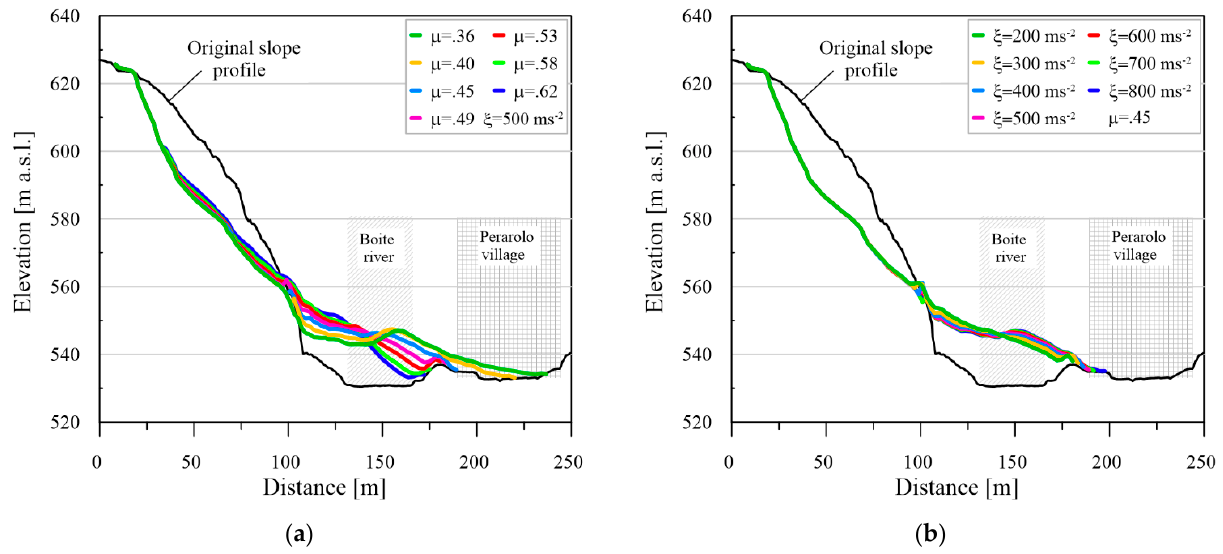
Figure 11. Height profiles of the sliding mass along cross-section C–C from the sensitivity analysis: ( a ) simulation with different values of friction angle (set 1); ( b ) simulation with different values of turbulence factor (set 2).